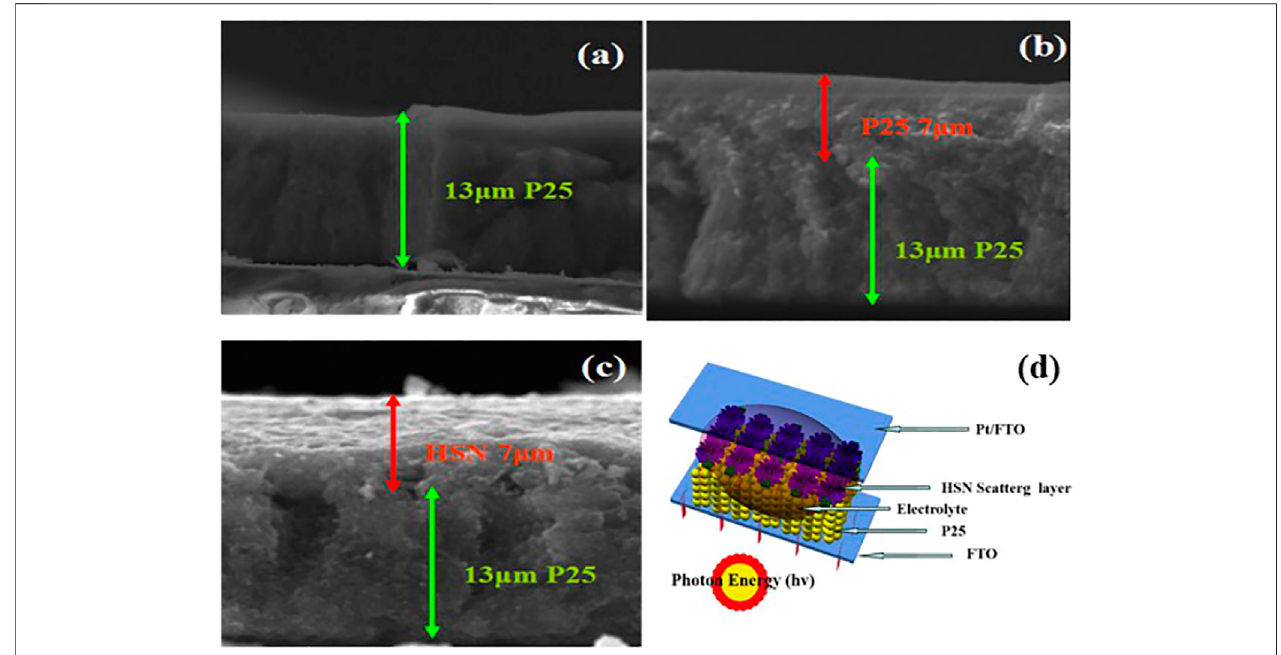
FIGURE 3| SEM of cross-section ofthe individual photoanodes: (A) single layer photoanode of TiO 2 P25 (13 μ m), (B) bi-layer fi lm consists of TiO 2 P25 absorbing layer (13 μ m) and TiO 2 P25 scattering layer (7 μ m), (C) bi-layer fi lm consists of TiO 2 P25 absorbing layer (13 μ m) and TiO 2 HSN scattering layer (7 μ m); (D) schematic diagram of the DSSC device, in which the photoanode consists of the TiO 2 P25 fi lm as under-layer and the TiO 2 HSN fi lm as upper-layer.